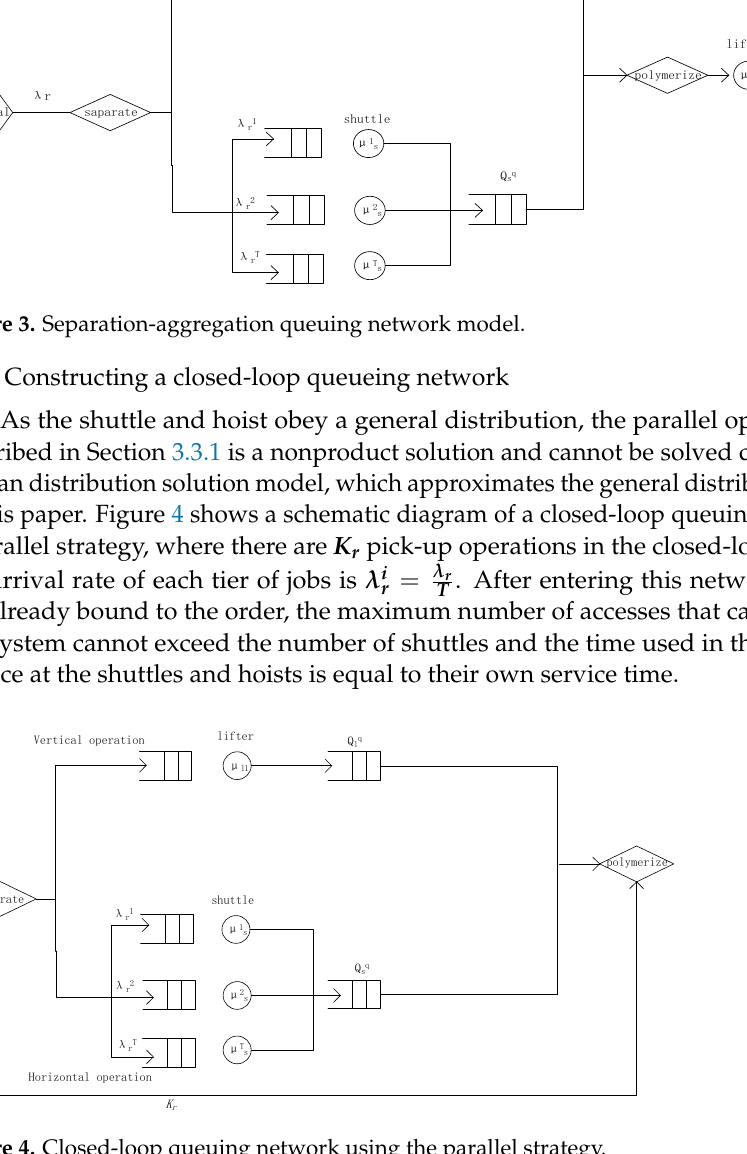
Figure 4. Closed-loop queuing network using the parallel strategy .